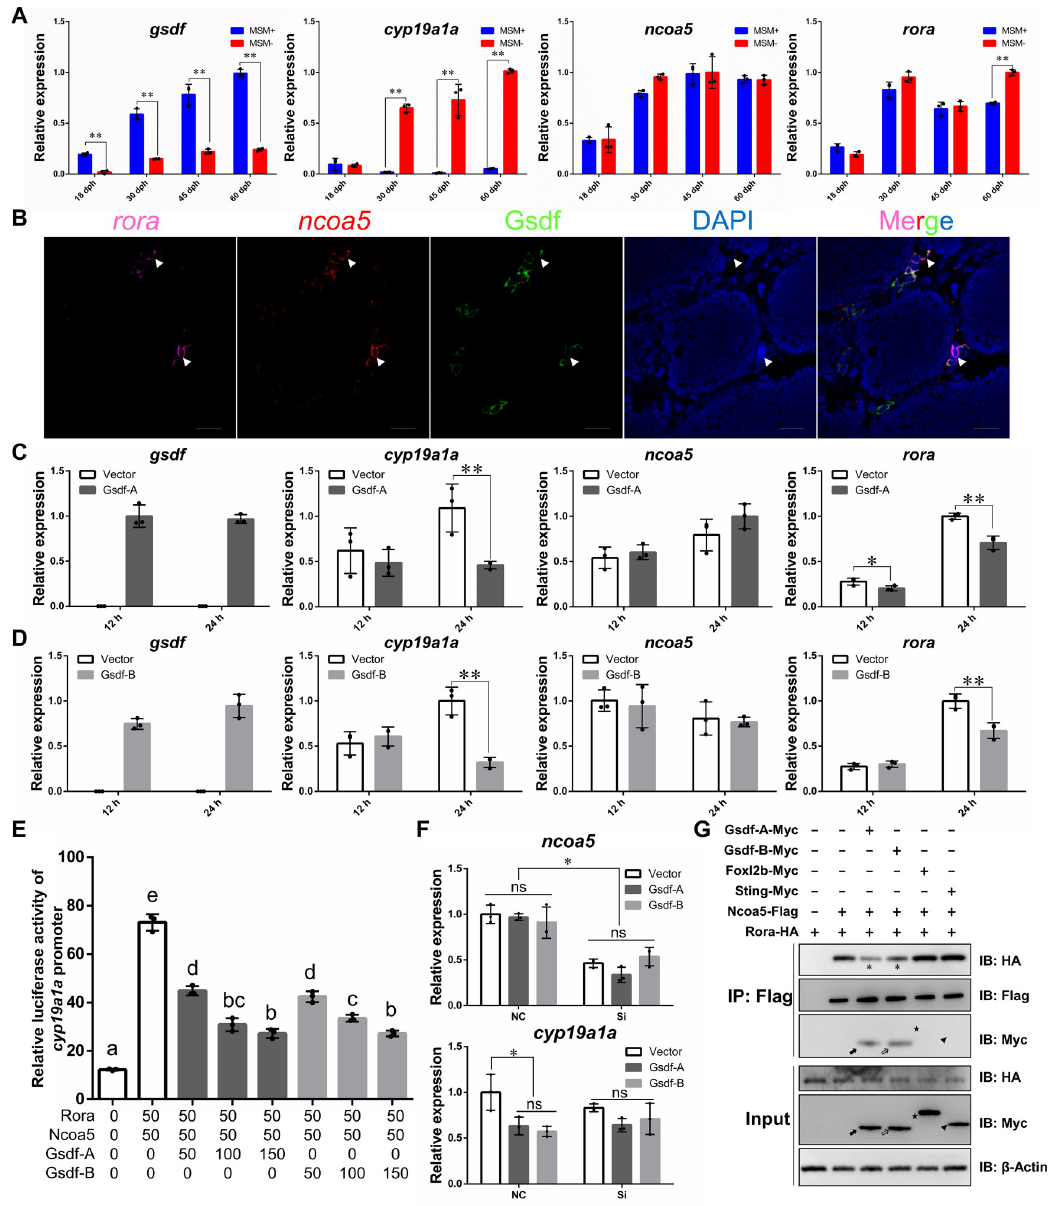
Fig 8. Gsdf inhibits cyp19a1a transcription via competitive interaction with Ncoa5. (A) Gene expression detected by qPCR in gonads during different developmental stages. MSM+, wild type males with MSM; MSM − , wild type females without MSM; (B) FISH analysis of the rora (Pink) and ncoa5 (Red) mRNA, and immunofluorescence analysis of the Gsdf protein (Green) in mature testis. Arrowhead indicates the somatic cells with expression of rora , ncoa5 , and Gsdf. Scale bars: 25 μ m. (C-D) Gene expression detected by qPCR after overexpression of Gsdf-A (C) and Gsdf-B (D) . The asterisks indicate the significant differences ( � P < 0.05, �� P < 0.01). (E) In the presence of Ncoa5 and Rora, Gsdf-A/Gsdf-B overexpression inhibits the promoter activity of cyp19a1a in a dosage-dependent manner in EPC cells. Different letters represent statistical differences ( P < 0.05). (F) Effect of ncoa5 ( ncoa5-A and ncoa5-B ) RNAi on the Gsdf-A/Gsdf-B-induced repression of cyp19a1a . qPCR analysis of ncoa5 and cyp19a1a in the EPC cells after transfection with different plasmids and ncoa5-A/B siRNA for 24 h ( � P < 0.05). NC, negative control; Si, ncoa5-A/B siRNA. (G) Co-IP of Ncoa5-Flag and Rora-HA with Gsdf-A-Myc, Gsdf-B-Myc, Foxl2b-Myc, and Sting-Myc in EPC cells transfected with the indicated plasmids. Anti-Flag Ab was used for Co-IP. Black arrow, gray arrow, star, and arrow head indicate bands of Gsdf- A-Myc, Gsdf-B-Myc, Foxl2b-Myc, and Sting-Myc, respectively. The asterisks indicate the decreased Rora-HA. The highest expression level in each qPCR analysis was used as control and defined as